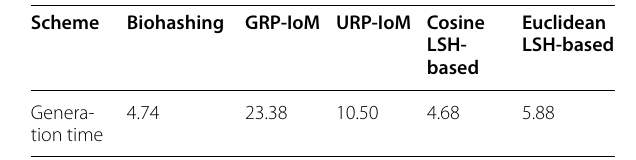
Table 5 Generation time comparison of different